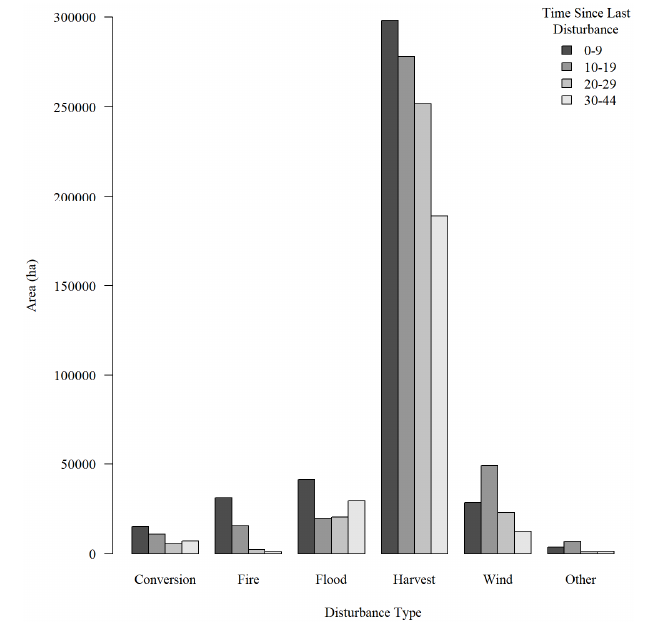
Figure 6. Time since last disturbance class areas summarized by change agents.